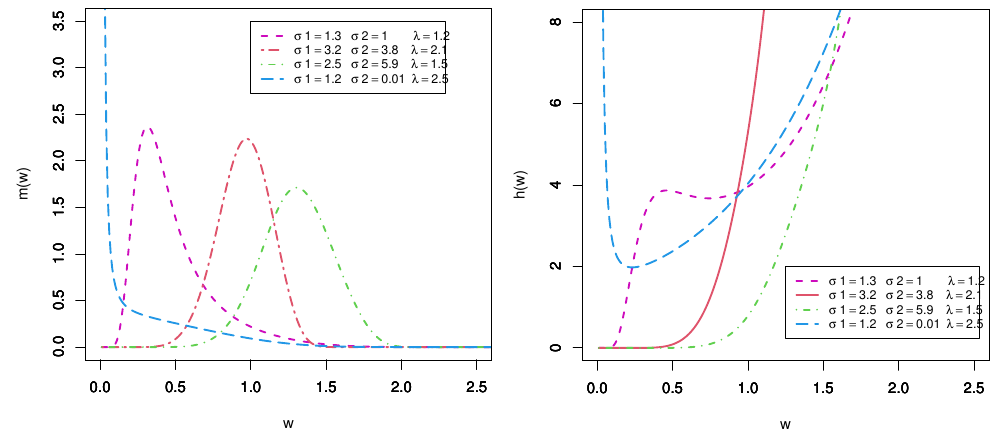
Figure 1. The PDF ( left panel ) and HRF ( right panel ) plots for the NMFWE